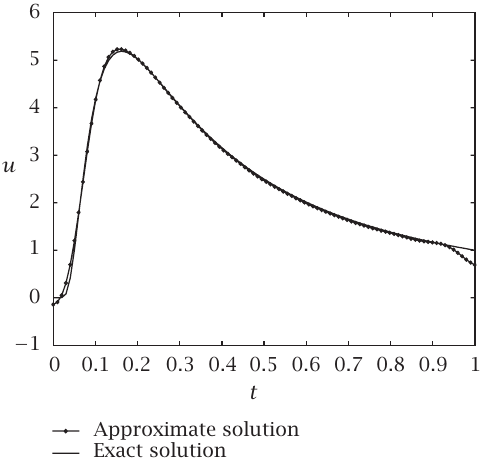
. = . = 4 . 39, α 0 2 . 5 × 10 − 6 (by formula (3.32)).